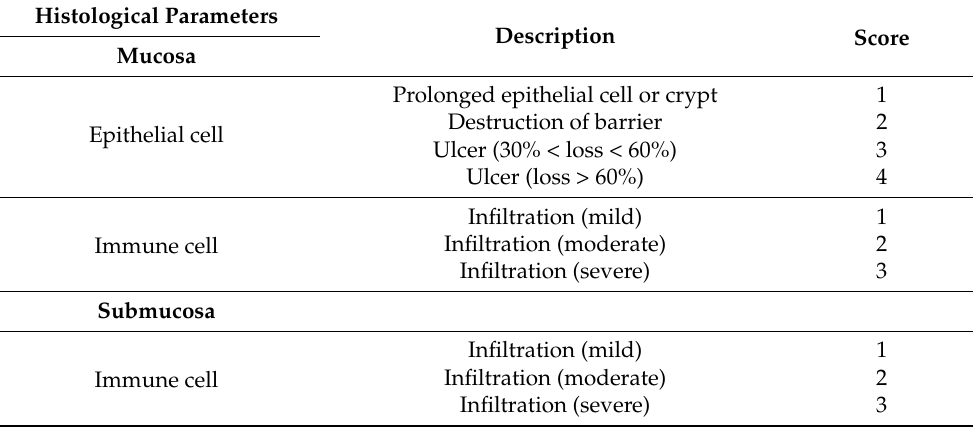
Table 1. Scores of histopathological inflammation.